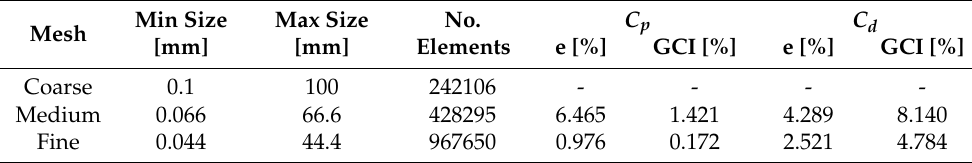
Table 2. Mesh details and GCI results for the C p and C d